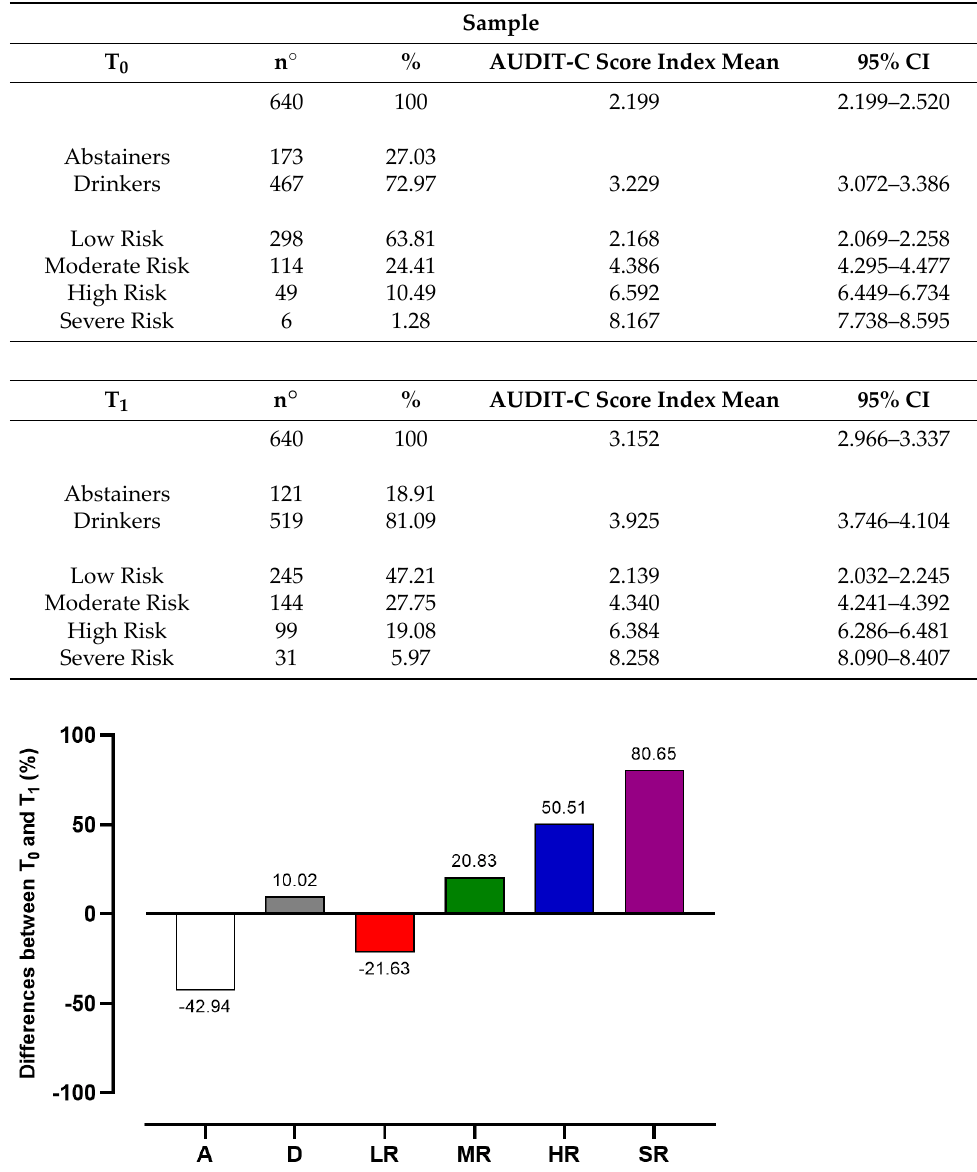
Figure 2. Differences in risk percentages over the time interval considered in our study, T 1 vs. T 0 . A = Abstainers; D = Drinkers; LR = Low Risk; MR = Moderate Risk; HR = High Risk; SR = Severe Risk. ** p < 0.01; *** p < 0.001 vs. T 0 . 3.2. Differences in Alcohol Consumption between Males and Females Given the data obtained on drinking behaviour in the sample analysed, we wondered whether there were differences between the percentages of male and female subjects re- garding alcohol consumption and differences in the risk related to alcohol consumption (Table 2). The analysis conducted by applying the Chi-square test did not reveal any significant differences in the percentages of alcohol drinkers between males and females ( χ 2 = 1.230, z = 1.109, p = 0.2675; χ 2 = 1.150, z = 1.072, p = 0.2836) in the two timeframes considered. When we evaluated the differences in the consumption of alcoholic beverages ob- tained from the analysis of the AUDIT-C test, the analysis of the data by the Chi-square did not reveal statistically significant differences both at T 0 and at T 1 between males and females regarding low risk ( χ 2 = 0.05162, z = 0.2272, p = 0.8203; χ 2 = 0.7793, z = 0.8828, p = 0.3774), moderate ( χ 2 = 0.3778, z = 0.6146, p = 0.5388; χ 2 = 0.06674, z = 0.2583, p = 0.7961) and